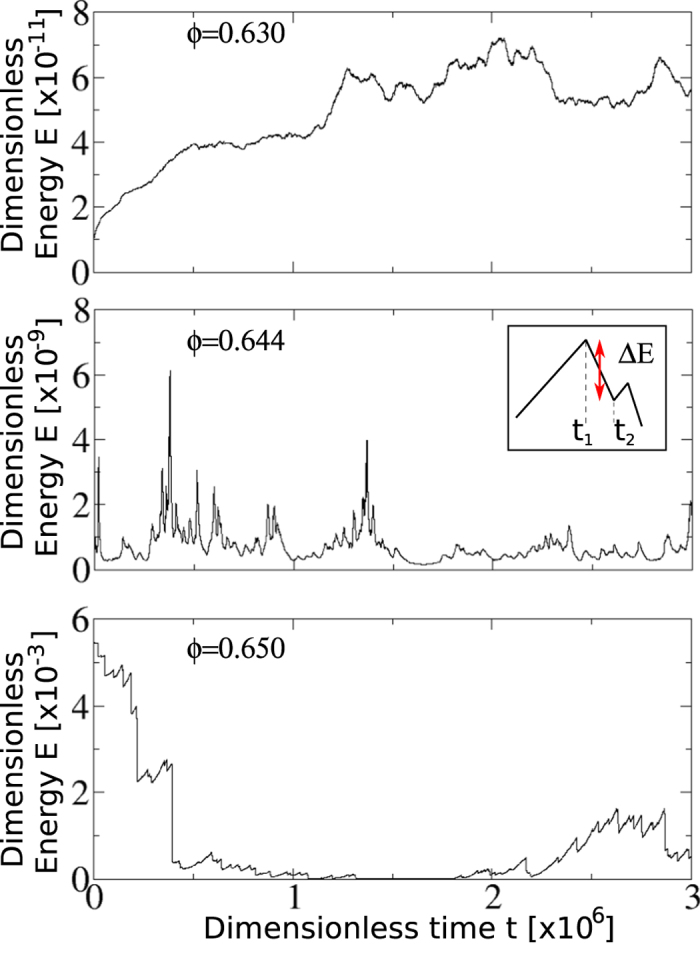
Typical time series of the elastic energy for a constant shear rate  and different volume fraction ϕ:(top) ϕ = 0.630, (middle) ϕ = 0.644, (bottom) ϕ = 0.650. As shown by the normalization constant of the vertical axes, the total energy and the energy releases explore different ranges of magnitude according to volume fraction. Inset in the middle panel shows how we estimate the energy release associated with a single avalanche.